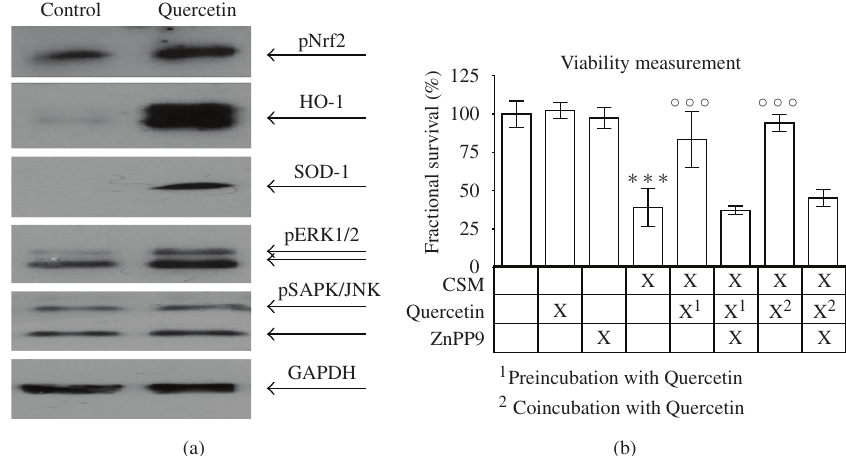
FIGURE 4: Quercetin protects primary human osteoblasts from CSM-induced damage via upregulation of anti-oxidative enzymes HO-1 and SOD-1. (a) Representative picture of a Western blot for pNrf2, HO-1, SOD-1, pERK1/2, and pSAPK in primary human osteoblasts treated with or without 100 μ M Quercetin. Quercetin induces the expression of HO-1 and SOD-1 and phosphorylation of pNrf2 and ERK1/2. GAPDH was used as loading control. (b) The HO-1 inhibitor ZnPP9 (10 μ M) reduces the protective effect of Quercetin (100 μ M/pre- and co-incubation) on primary human osteoblasts ( N = 3 , n = 4 ) treated with CSM (OD 320 = 0.8) for 4 h. ∗∗∗ P < 0 . 001 compared to untreated cells; ◦◦◦ P < 0 . 001 compared to CSM-treated